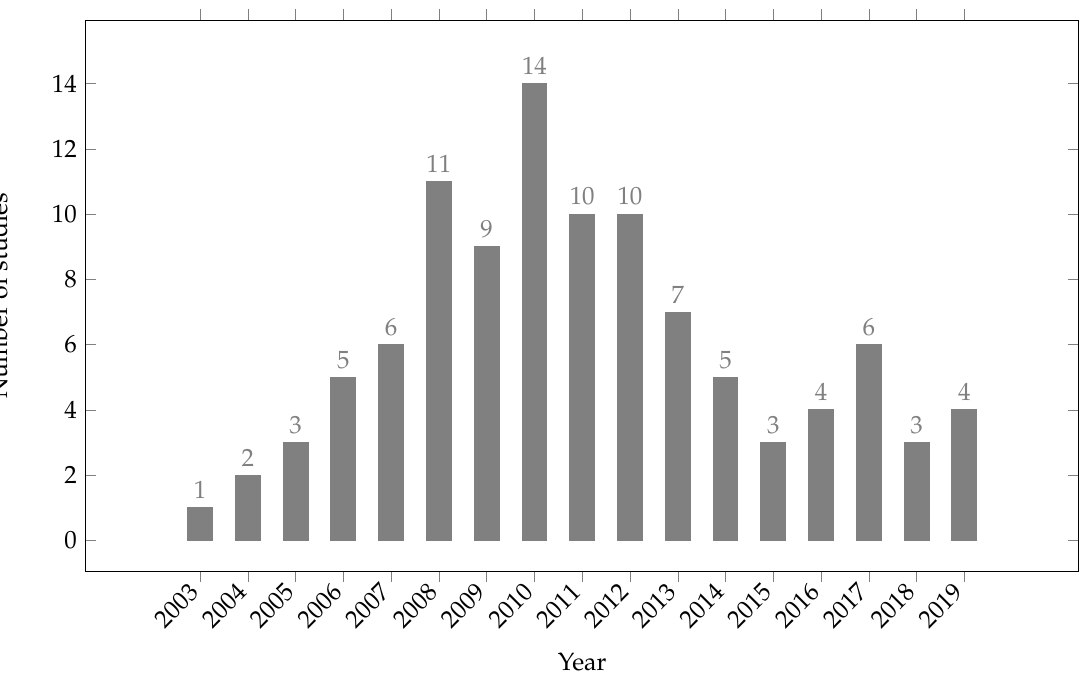
Figure 1. Year-wise distribution of selected